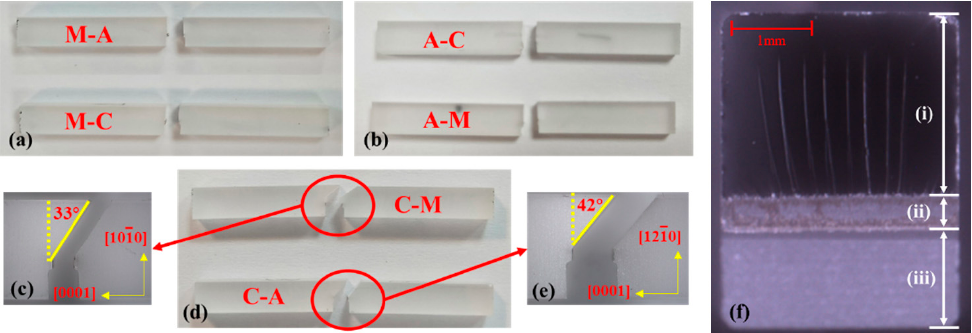
Figure 7. Fractured specimens. ( a ) Fracture of M-plane sapphire, where “M” is the cross-section of the sapphire sample, “A” and “C” are the loaded surfaces of the sapphire sample. ( b ) Fracture of A-plane sapphire, where “A” is the cross-section of the sapphire sample, “C” and “M” are the loaded surfaces of the sapphire sample. ( c ) Fracture of C-plane sapphire when loading M-plane. ( d ) Fracture of C-plane sapphire, where “C” is the cross-section of the sapphire sample, “M” and “A” are the loaded surfaces of the sapphire sample. ( e ) Fracture of C-plane sapphire when loading A-plane. ( f ) Fracture morphology with (i)-fracture zone, (ii)-V-notch zone, (iii)-U-notch groove zone. The cleavage direction of M-plane and A-plane sapphires are parallel to the cross- section. It is obvious that the cleavage direction of C-plane sapphire is deflected, it is not along the cross-section of the sample. In addition, the fracture toughness of C-plane sapphire is the highest. According to the crystal structure of sapphire and the bond strength between different atoms, the results of experience are consistent with the expectation. In the C-plane sapphire tests, the angle between the cleavage direction and the cross-section